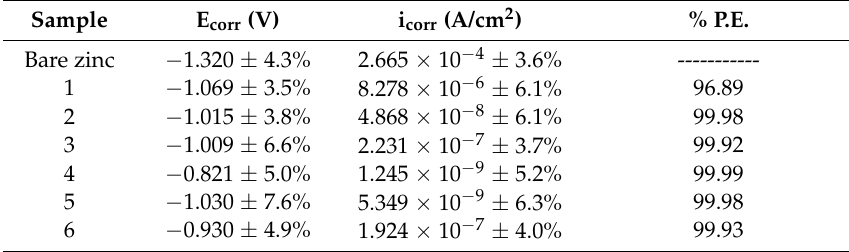
Figure 7. Potentiodynamic polarization curves of samples immersed in a 3.5% NaCl solution at room temperature (25 °C). Table 3. Electrochemical parameters obtained by Tafel extrapolation in 3.5% NaCl solution.